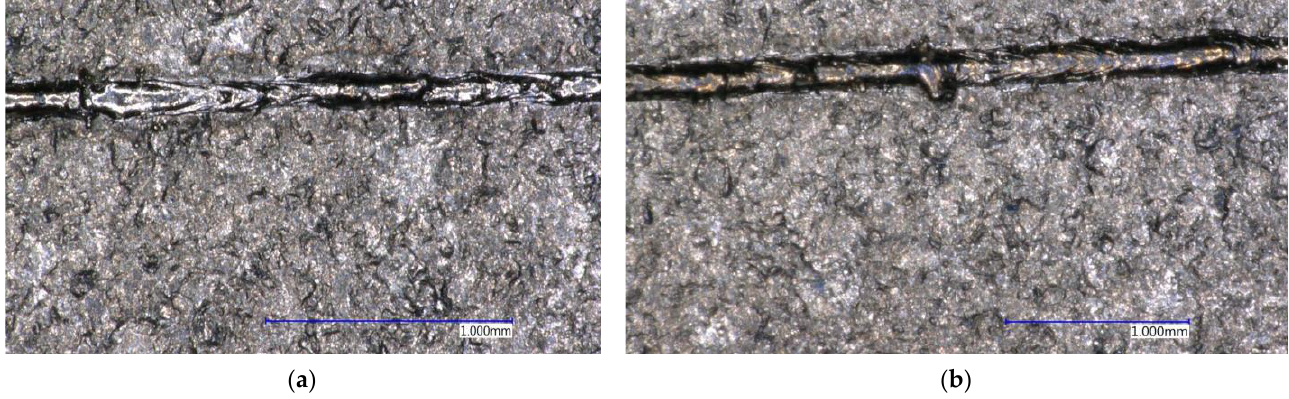
Figure 7. ( a ) Orientation of the samples in the printer workspace; ( b ) Printed test samples for tensile test.